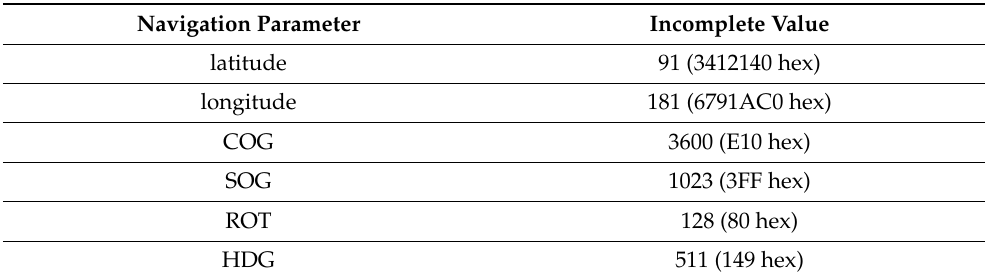
Table 1. Values applied in the case of incomplete dynamic data in AIS position reports transmitted by class A